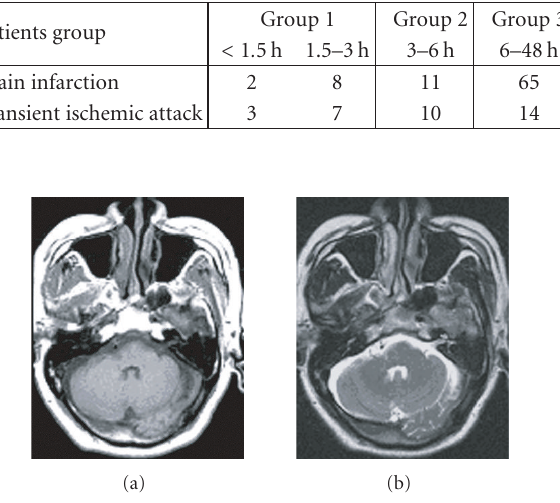
Figure 1: A 46-year-old male. Hyperacute stage (1.5 hour). T1- weighted image (a) and T2-weighted image (b). No abnormality was found.